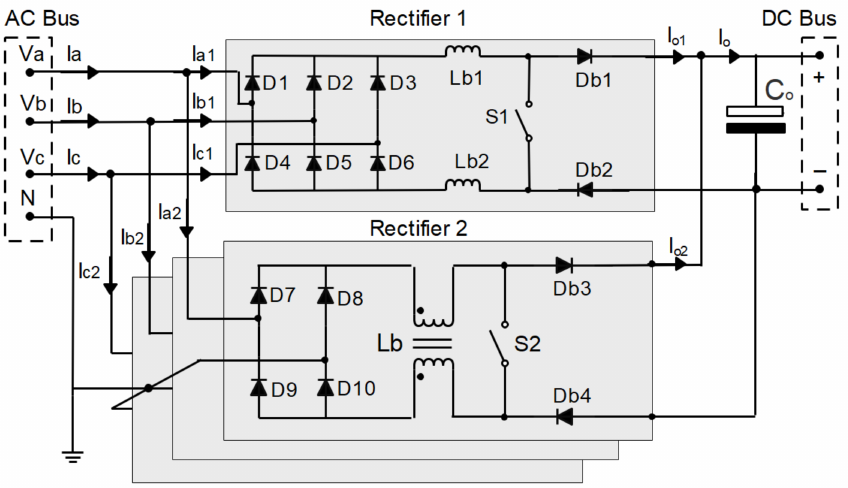
Figure 16. Configuration of the electrical circuit of the UHTR-BR1//BR2.